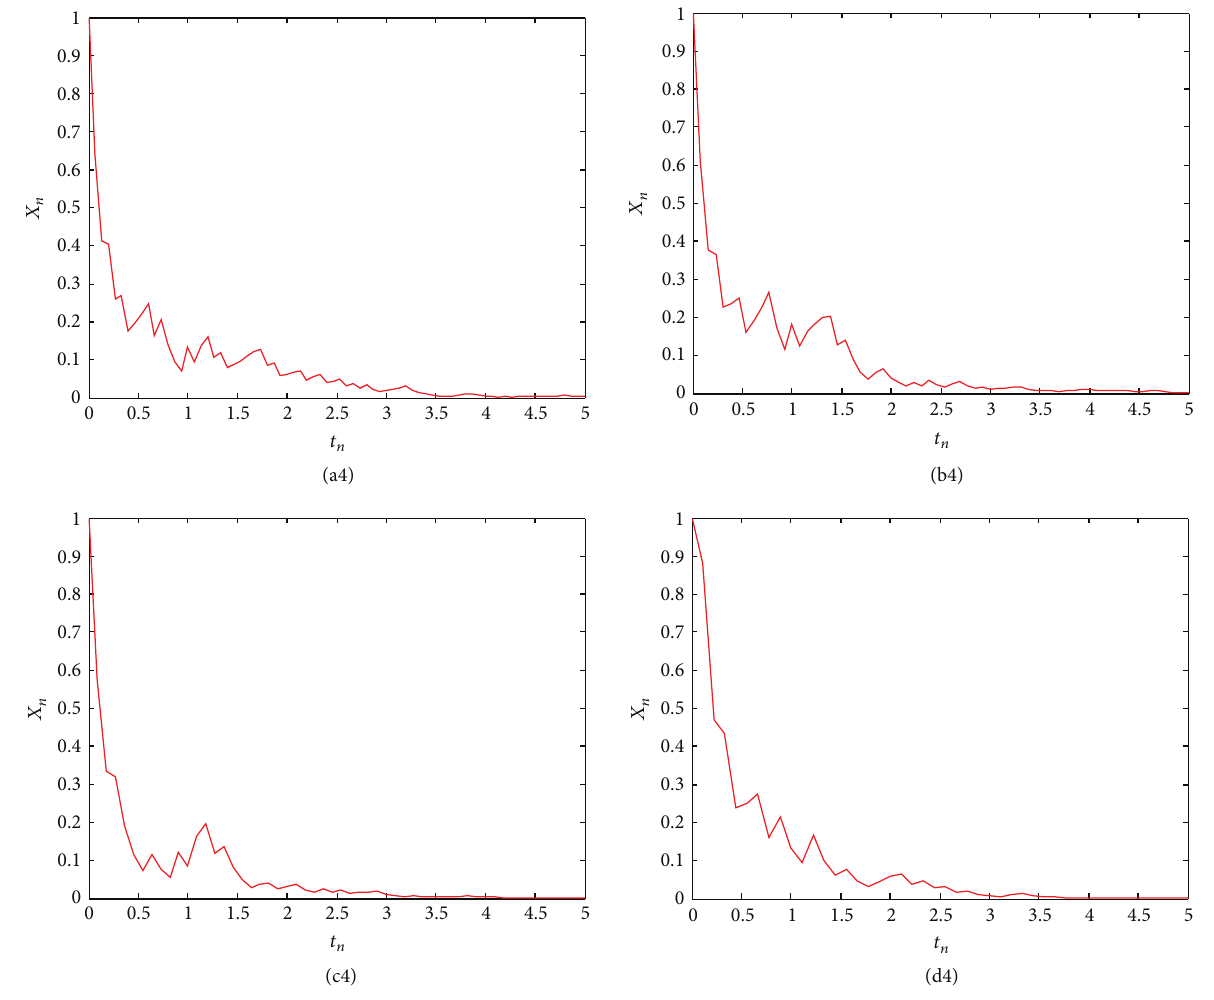
Figure 4: Simulations with the balanced method for (7) with 𝑎 = −5, 𝑏 = 1, 𝑐 = 1 , and 𝑑 = 0.2 . ( a 4) ℎ = 1/15 , ( b 4) ℎ = 1/13 , ( c 4) ℎ = 1/11 , and ( d 4) ℎ = 1/9